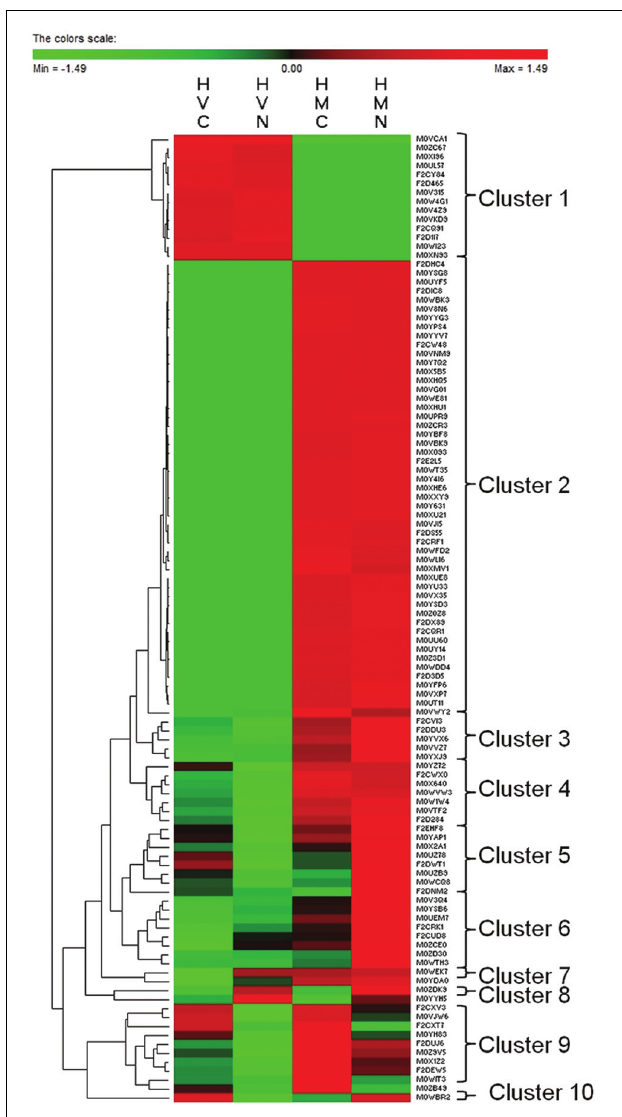
FIGURE 4 | Cluster analysis of 108 proteins identified in at least two experimental variants except for the variants HVC ∩ HMC (21), HVN ∩ HMN (15), HVC ∩ HMN (4), and HVN ∩ HMC (0). HVC, H. vulgare , control treatment; HVN, H. vulgare , 300 mM NaCl; HMC, H. marinum , control treatment; HMN, H. marinum , 300 mM